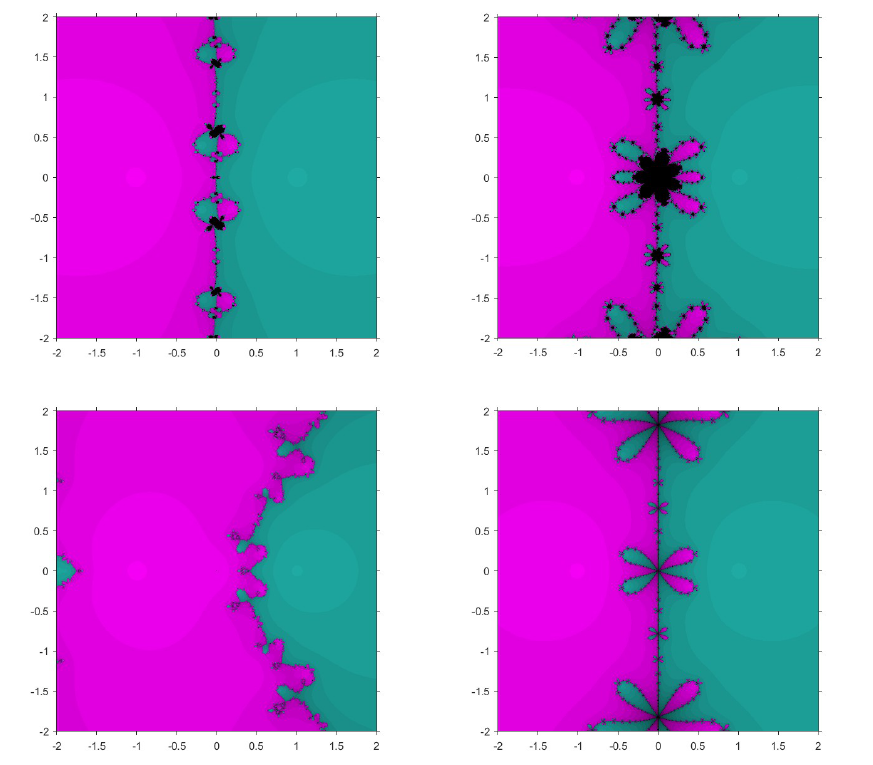
Figure 1. Basins of attraction for PM , SM , AM 1 , and CM , respectively, for p 1 ( z ) .